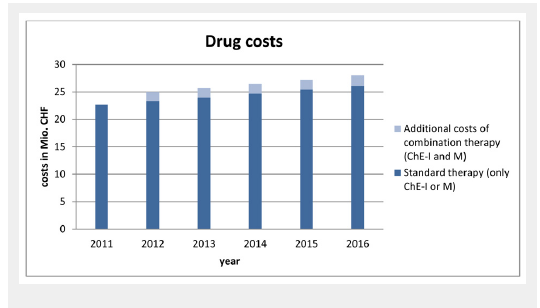
Calculated medication costs for the years 2011–2016.